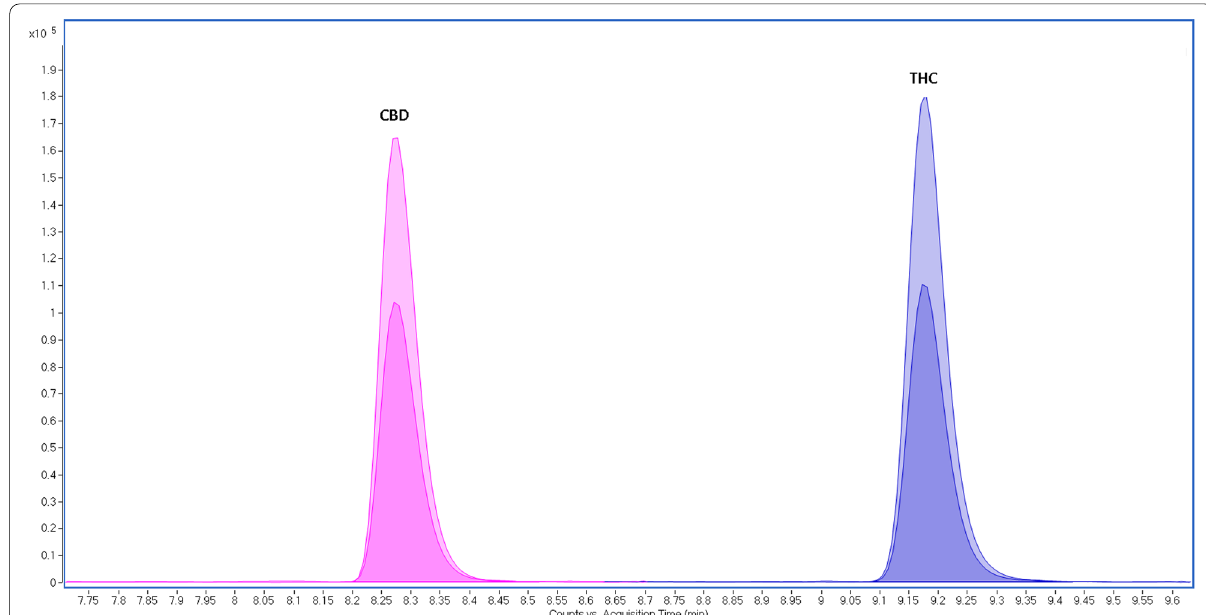
Fig. 1 CBD and THC chromatographic separation at 8.22 and 9.13 min, respectively. The chromatogram was extracted from an injection of a methanolic solution at 25